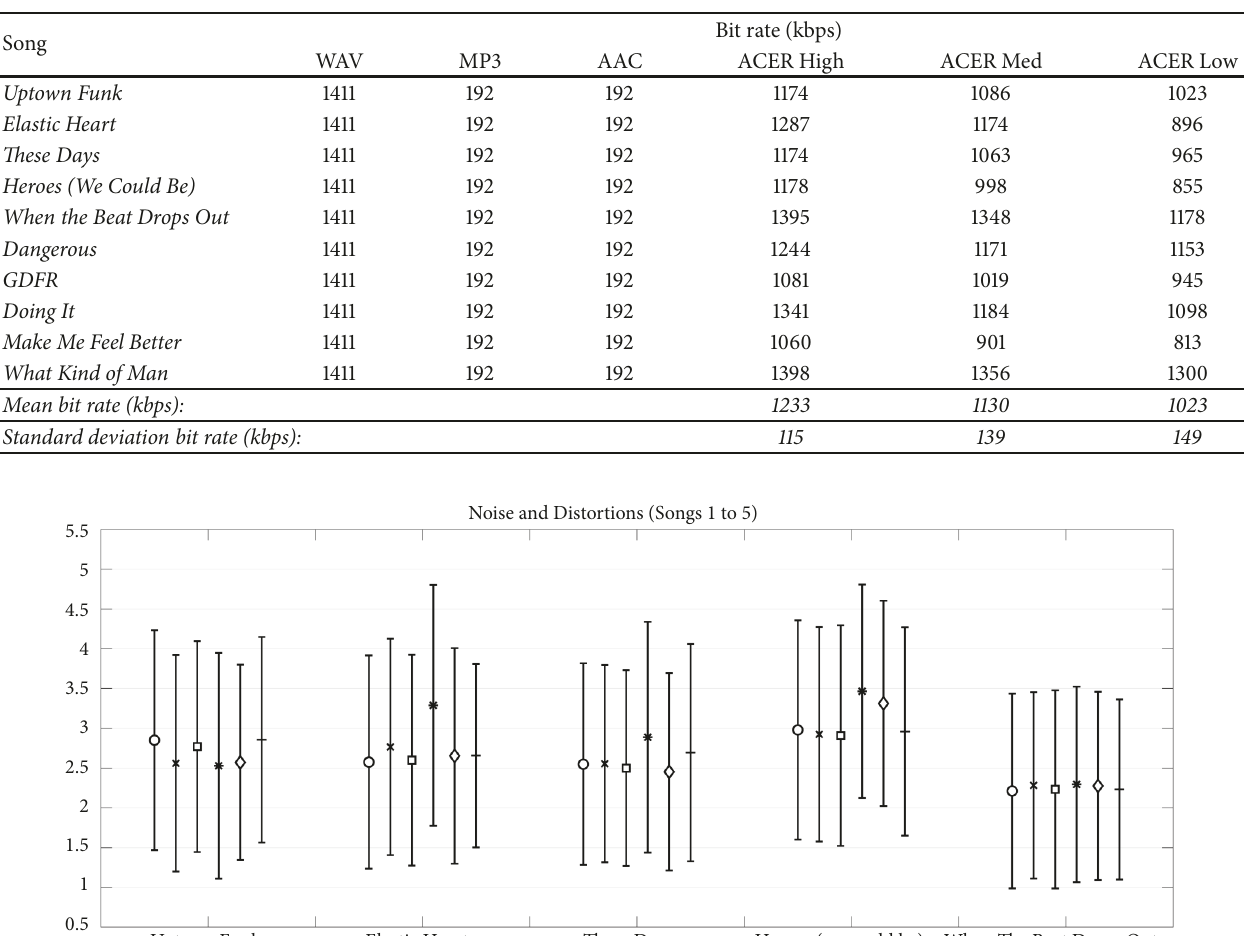
Table 2: Bit rates achieved for each combination of codec and song.